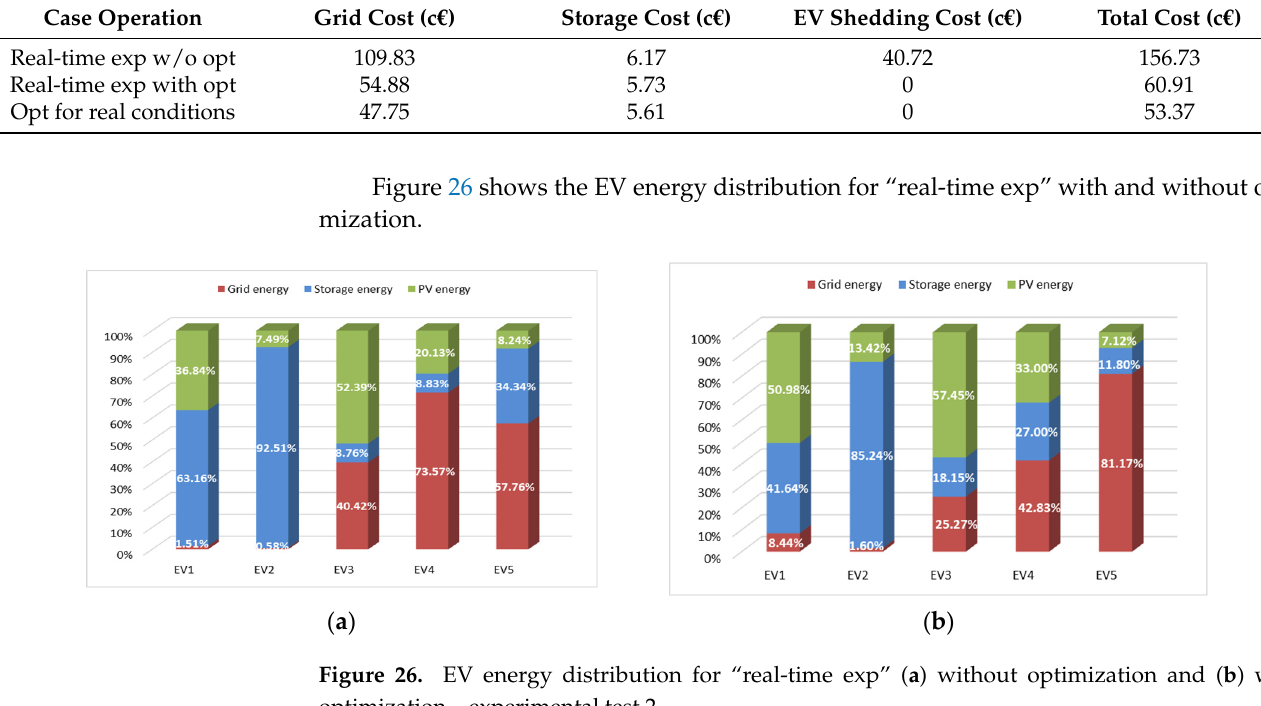
Table 5. Energy system cost—experimental test 2.